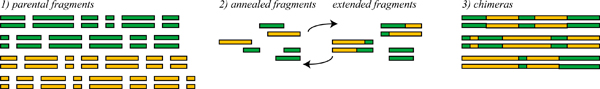
Basic steps in gene shuffling protocol (following [30]). (1) Parental genes are stochastically fragmented. (2) The fragments are denatured, and strands with sufficient complementarity are annealed and extended. Cross-overs are formed when the complementary strands are from different parents and can be extended to complete fragments. The process is repeated for multiple rounds, generating additional fragments and cross-overs. (3) Ultimately a chimeric library is generated, some of whose members represent full-length genes, as shown.